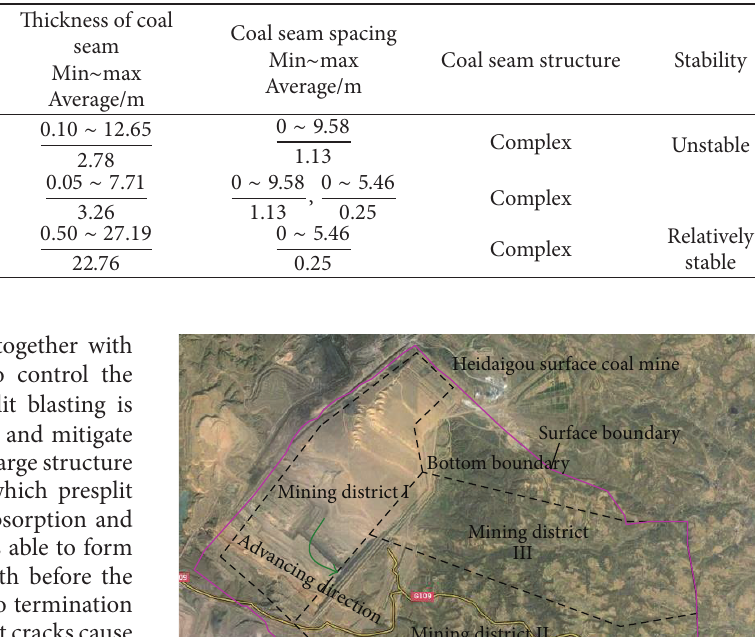
Table 1: Basic information of the minable coal seam.